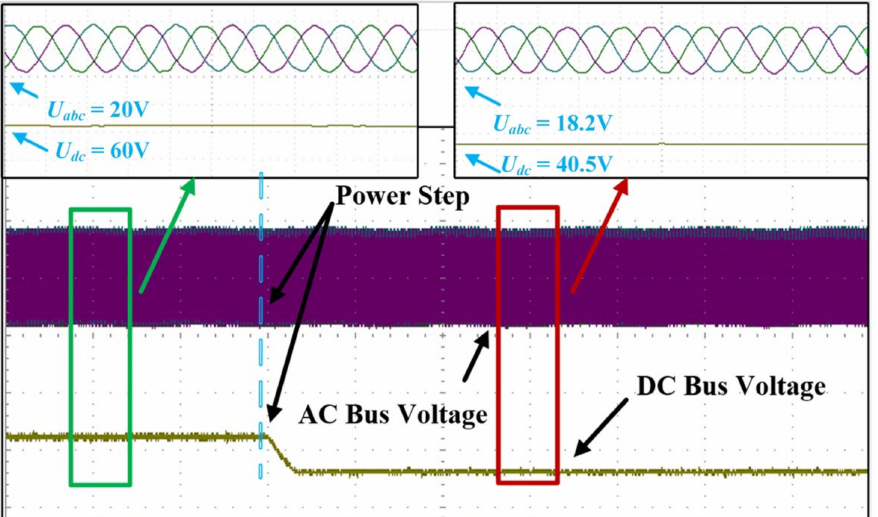
Figure 22. AC and DC bus voltage waveforms of microgrids when the battery is in charging mode (CPLs power varies from 20 W to 60